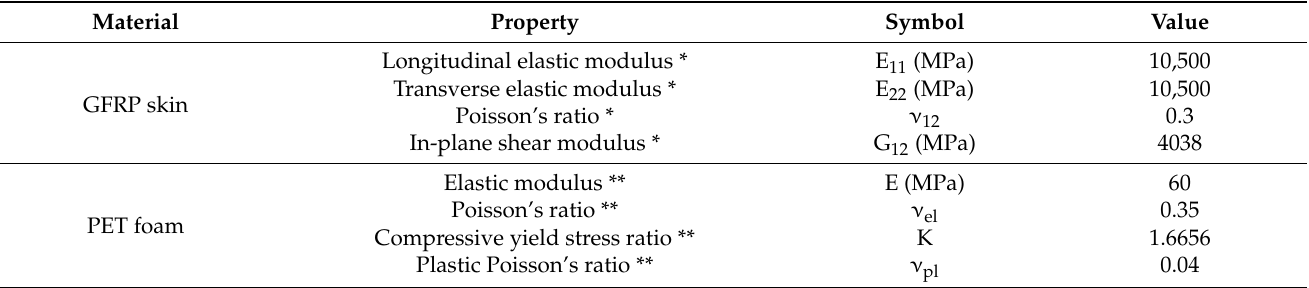
Table 2. Material’s properties of the GFRP skins and crushable foam’s parameters of the PET foams.